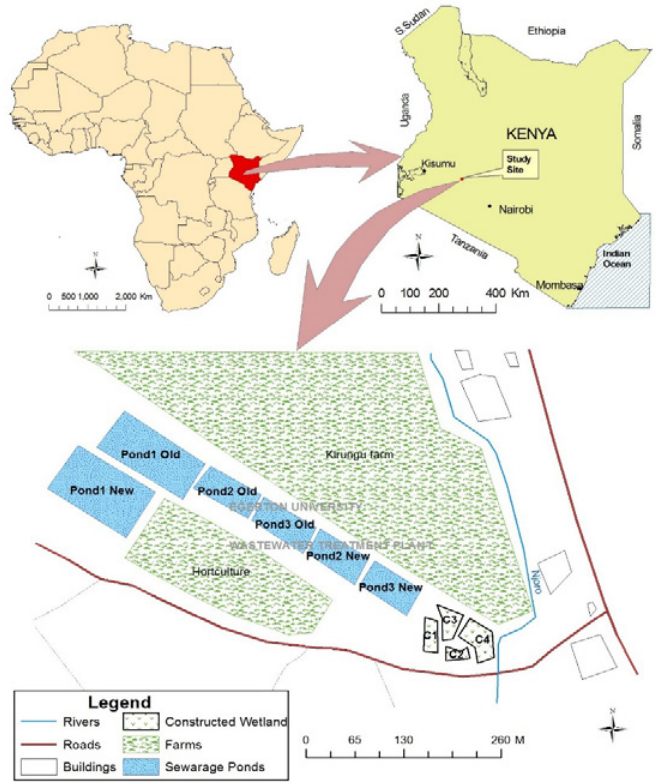
Fig. 1: Geographic location of the study area in Egerton University in Kenya